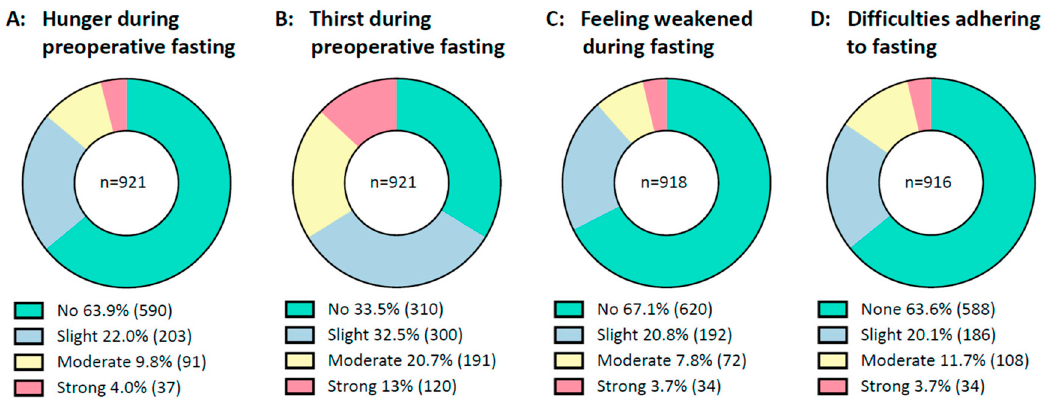
Figure 2. Condition during fasting. From right to left are shown: ( A ): Patients’ feelings of hunger during preoperative fasting. ( B ): Patients’ feelings of thirst during preoperative fasting. ( C ): Patients’ feelings of weakness during preoperative fasting. ( D ): Patients’ difficulties in adhering to fasting recommendations. Data are presented as a circle chart. Green indicates “no or none”, blue indicates “slight”, yellow indicates “moderate” and red indicates “strong”. Bellow the chart, the percentage of answers is displayed next to the legends. The number of patients is displayed in parentheses behind the percentage. n =